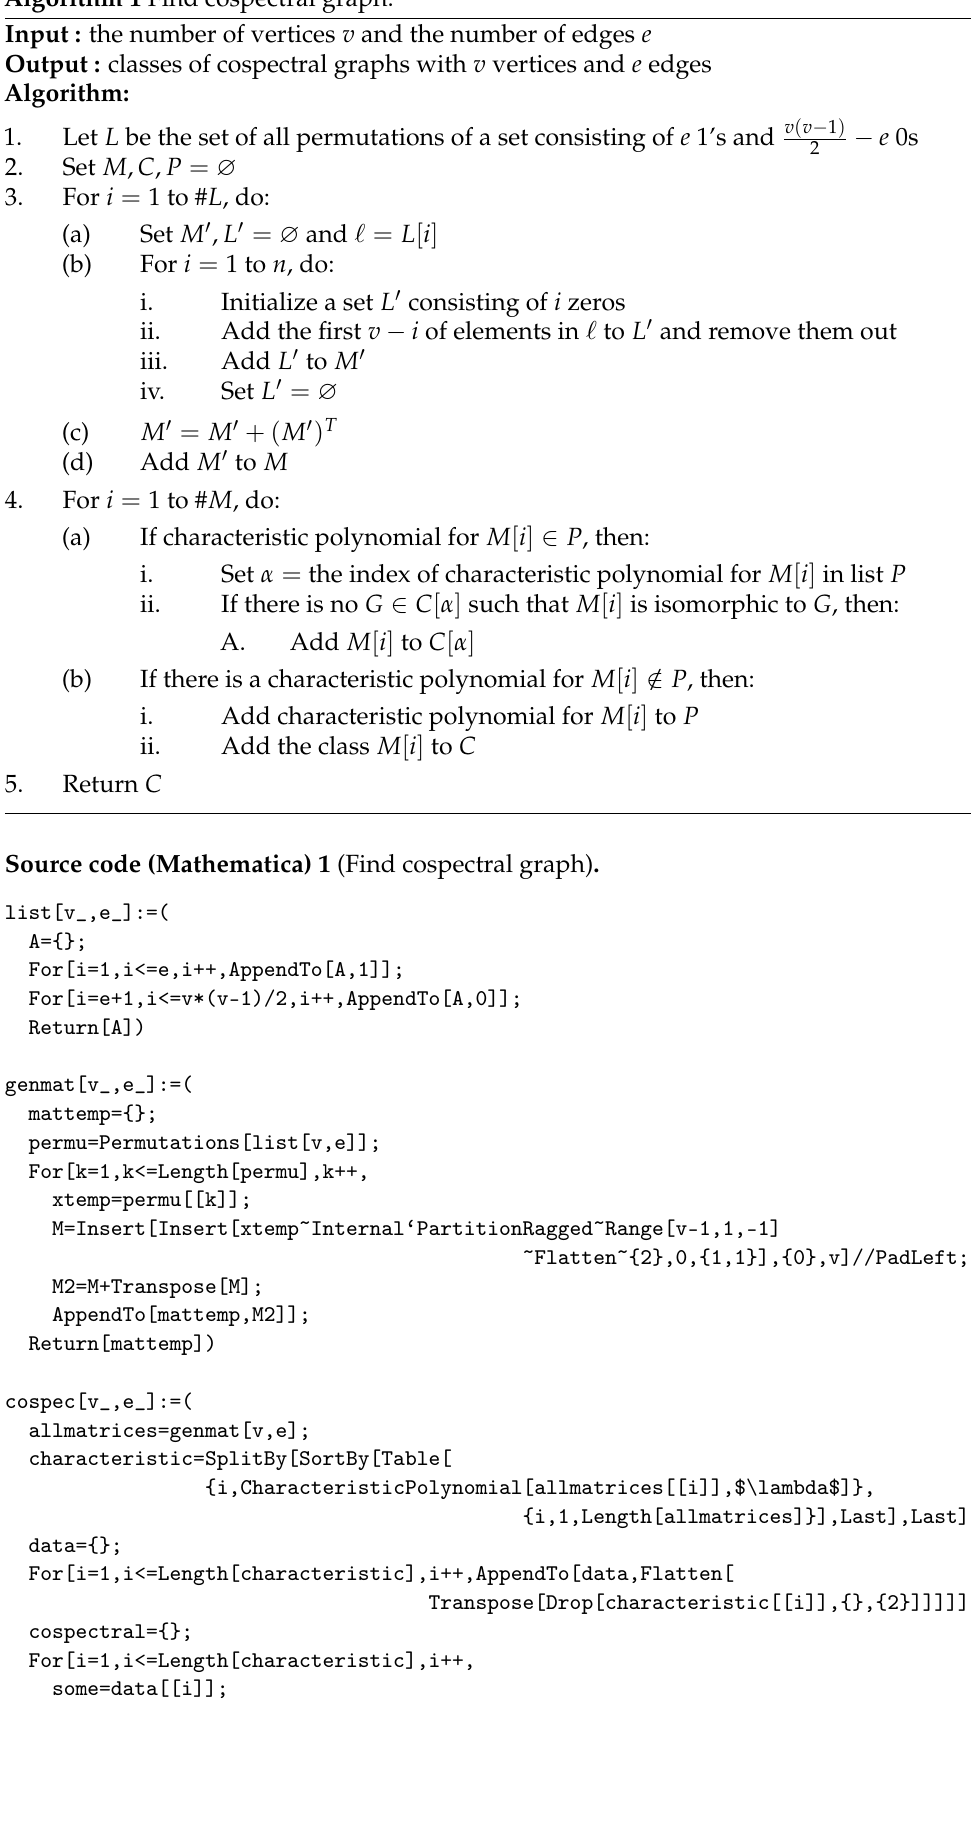
Algorithm 1 Find cospectral